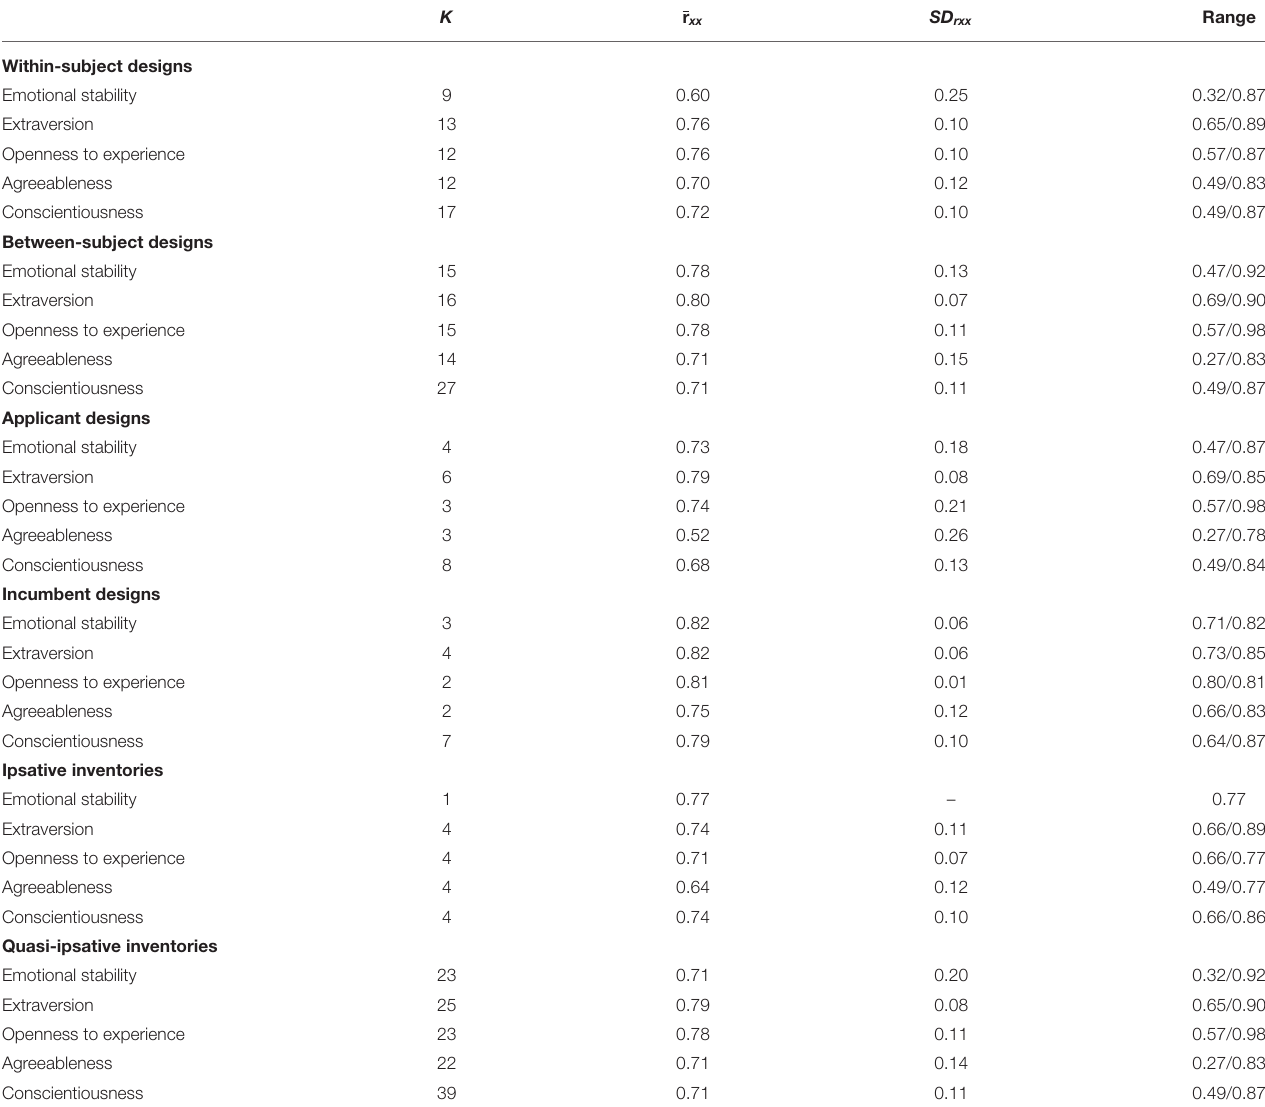
TABLE 2 | Reliability distributions for the variables (Big Five). K SD rxx